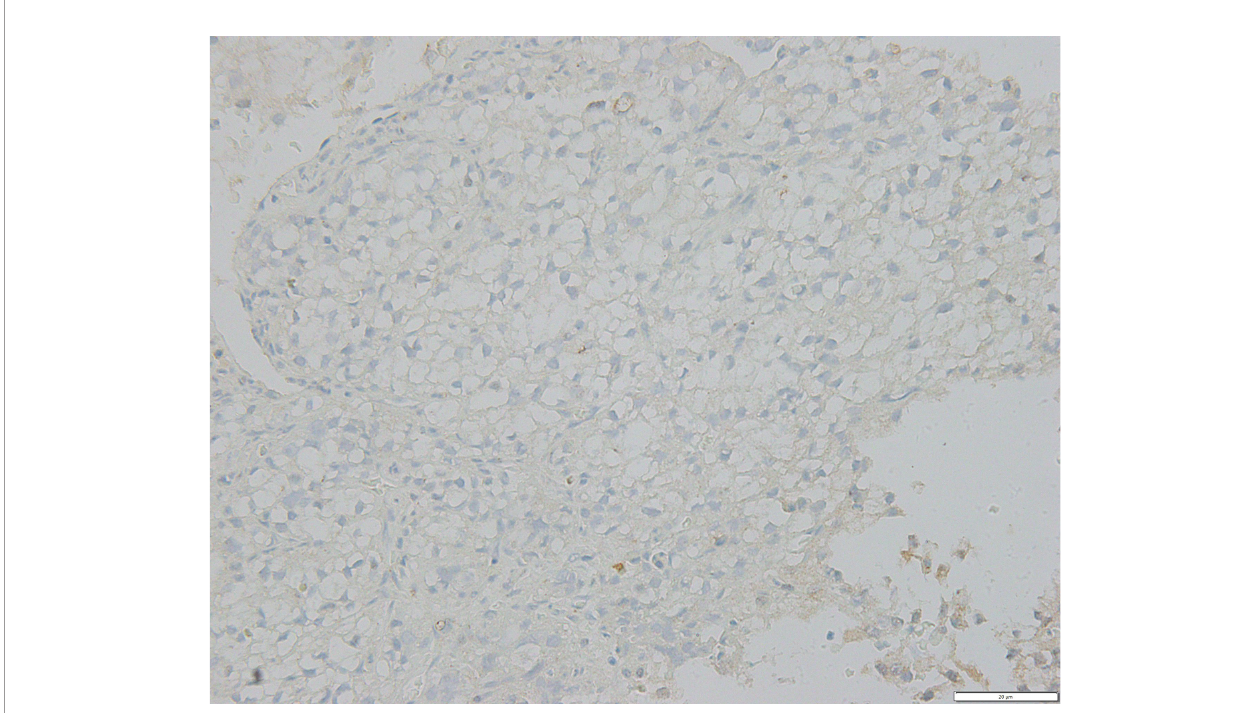
FIGURE 2 | FFPE tissue photomicrograph from metastatic lesion stained for negative PD-L1 assessment. PD-L1, programmed cell death receptor-ligand